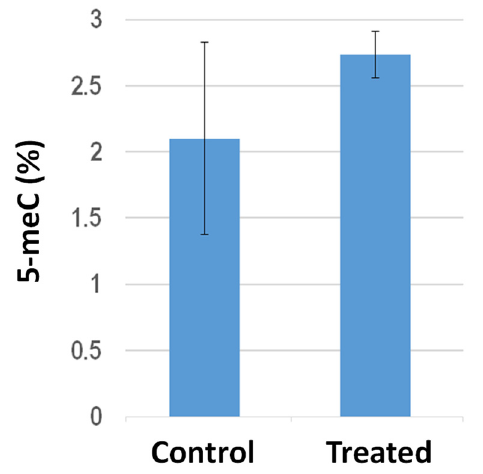
Figure 4. Histogram representing the global 5 meC level measured with ELISA-based assays in shoots from tomato plants either untreated (control) or exposed (treated) to S. violaceoruber cultures. Data are presented as a mean ± SE. Quantitative group difference is statistically significant ( p < 0.05) according to the one-way ANOVA test.